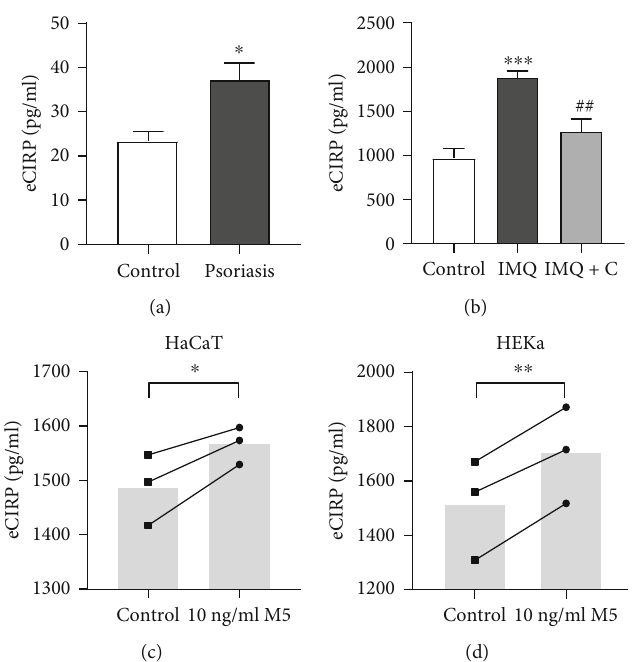
Figure 2: Levels of eCIRP in psoriasis. (a) Detection of eCIRP serum levels in psoriasis patients ( n = 30 ) and normal controls ( n = 10 ) by ELISA. (b) eCIRP levels in the sera of IMQ-induced psoriatic mice were measured by ELISA ( n = 5 mice/group). IMQ: IMQ-induced psoriatic mice; IMQ+C: IMQ-induced psoriatic mice treated with calcipotriol. HaCaT (c) and HEKa (d) cells were stimulated with M5 (10 ng/ml each of IL-1 α , IL-17A, IL-22, oncostatin M, and TNF- α ) for 24 hours. The eCIRP levels in the culture supernatants were determined using a commercial ELISA kit. Data are expressed as the mean ± SEM . ∗ P < 0 : 05 , ∗∗ P < 0 : 01 , and ∗∗∗ P < 0 : 001 vs. control; ## P < 0 : 01 vs.